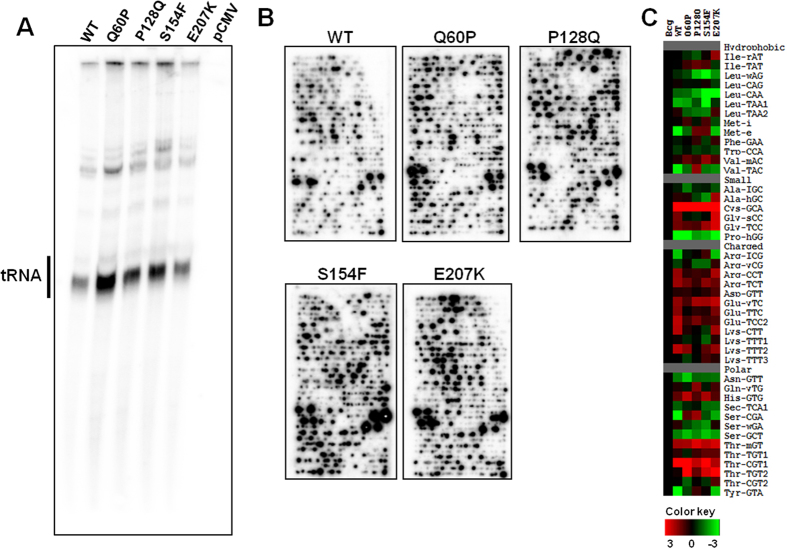
Interaction of tRNA with disease-associated MEK2 mutants.(A,B) HEK293T cells transfected with Flag-tagged, wild type MEK2 or MEK2 mutants previously associated with developmental defects, cancer development or resistance to targeted therapy. The cells were then exposed to UV to crosslink RNA and protein in live cells and processed for CLIP-Chip using specific antibody against MEK2. PAGE analysis was performed to evaluate MEK2-tRNA interactions. The indicated tRNA bands were cut out for microarray analysis and for semi-quantitative analysis of CLIP-Chip array results. (C) Anticodon specific tRNA signals are calculated and expressed as log2(X), where X indicates values relative to the background (Bcg) signal present in HEK293T cells (data from our previous work4). Relative abundance of specific tRNAs are shown as heat map and are indicated with colors ranging from green (low) to red (high).